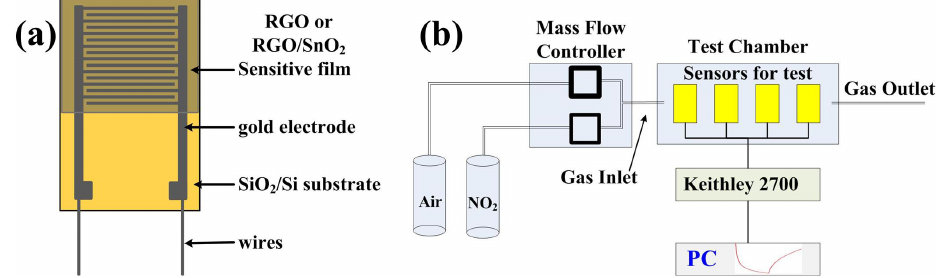
Figure 1. Schematic illustration of ( a ) the as-fabricated gas sensors and ( b ) measurement